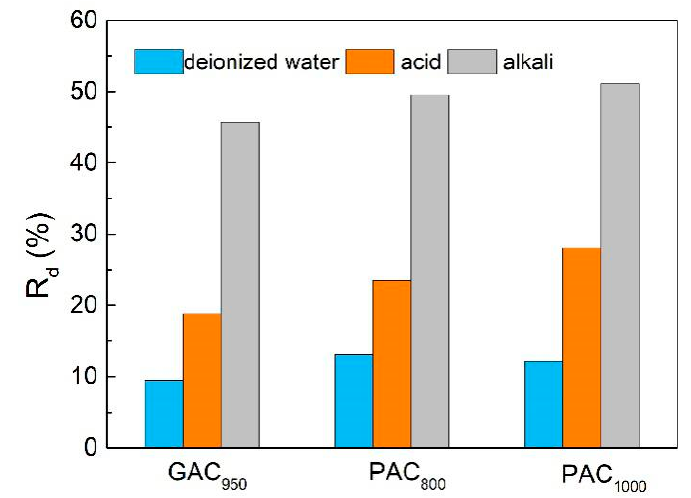
Figure 11. The phenol release percentage of AC.